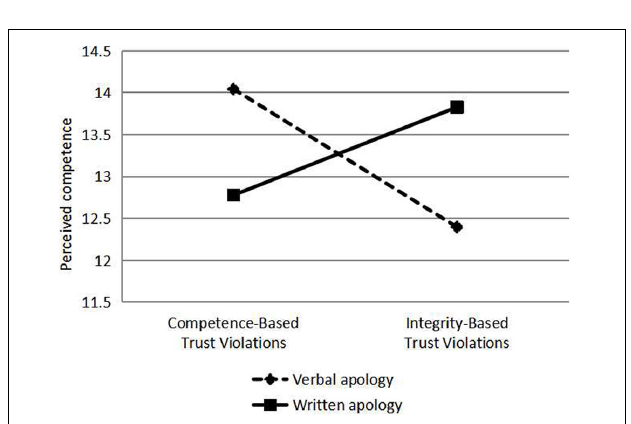
FIGURE 4 | The effects of violation type and response on willingness to risk.